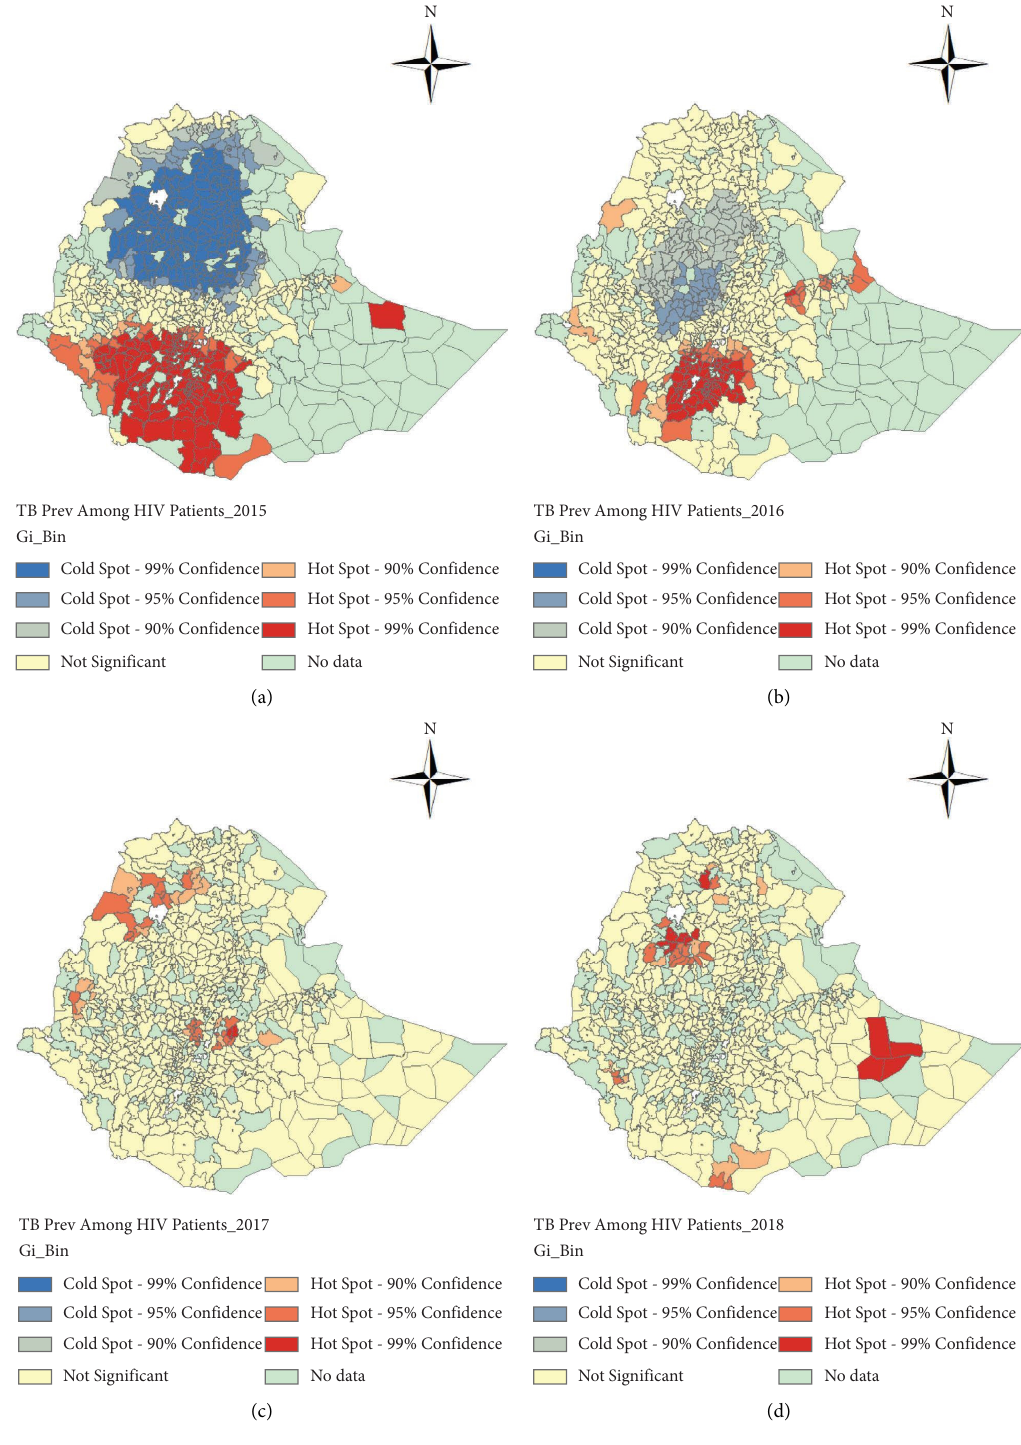
Figure 5: Spatial clustering of tuberculosis prevalence among PLHIV at district levels in Ethiopia from 2015 to 2018 using the Getis–Ord G ∗ statistic. (a) 2015. (b) 2016. (c) 2017. (d)